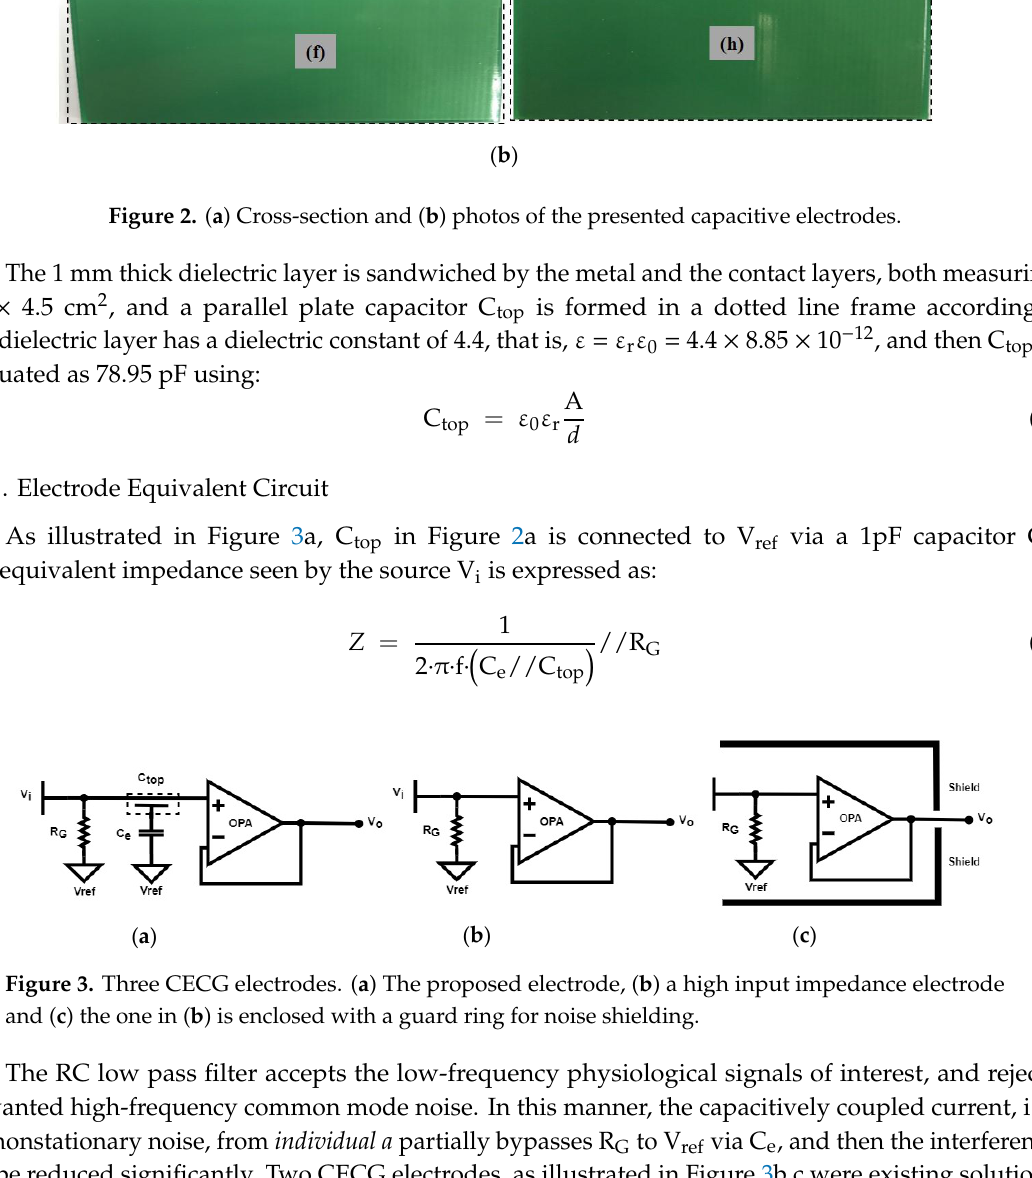
Figure 3. Three CECG electrodes. ( a ) The proposed electrode, ( b ) a high input impedance electrode and ( c ) the one in ( b ) is enclosed with a guard ring for noise shielding.